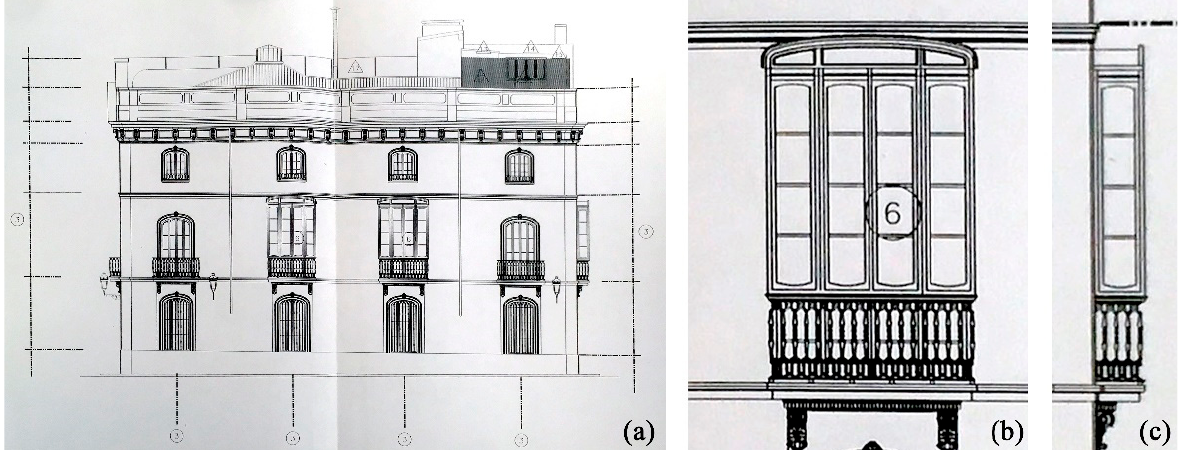
Figure 16. ( a ) CAD drawing of the eastern façade in 1995 before renovation. The two central windows of the second floor are shown with a glass housing, which was later removed; ( b ) front view of the housing; ( c ) side view. Architect Francisco Esquembre Casañ. Intermediate Municipal Archive of the Valencia City Council. Urban Police, file number 608, year 1995.